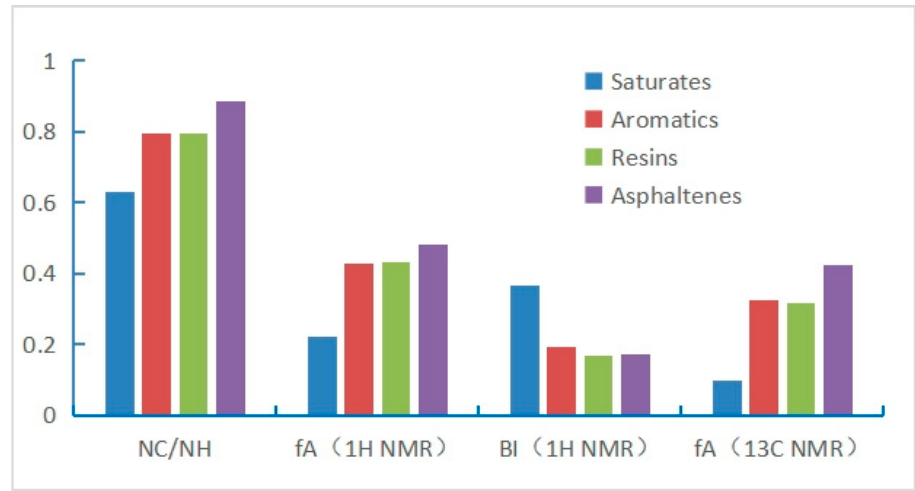
Figure 9. The average structural parameters of four